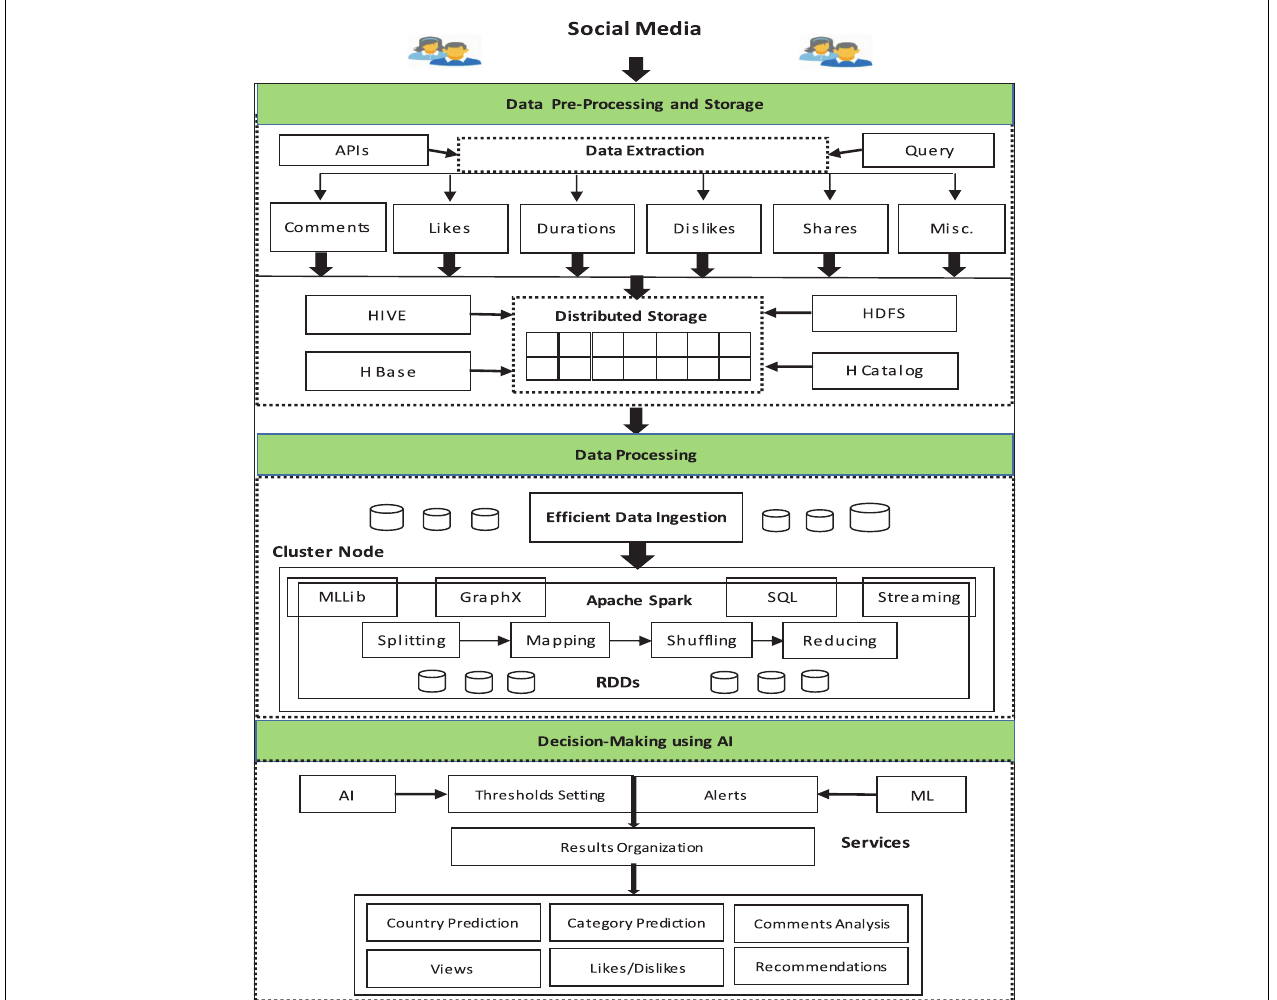
FIGURE 2 | Proposed